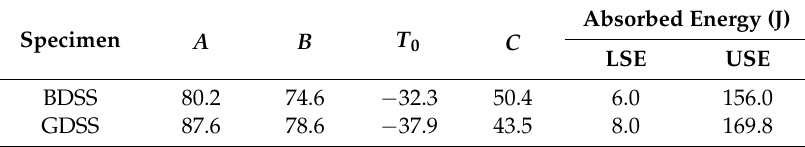
Figure 7. Fracture Charpy impact energies of BDSS and GDSS as a function of temperature from − 196 ◦ C to 200 ◦ C. Table 3. Impact of energy transition curve parameters and absorbed energy obtained from Charpy impact tests from the fabricated